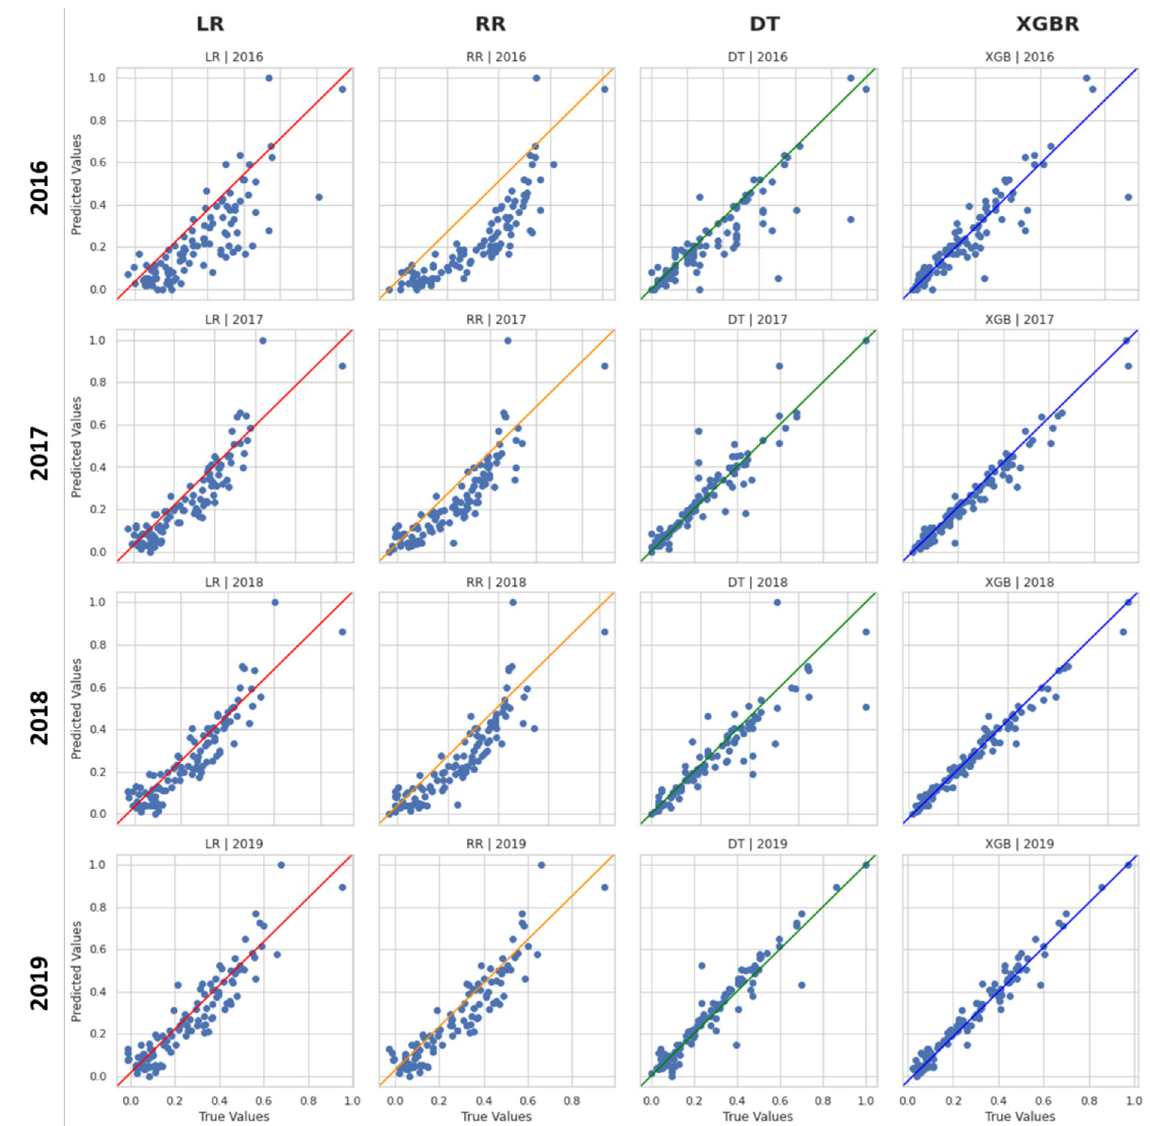
Fig 8. Scatter plot matrix for provincial models’